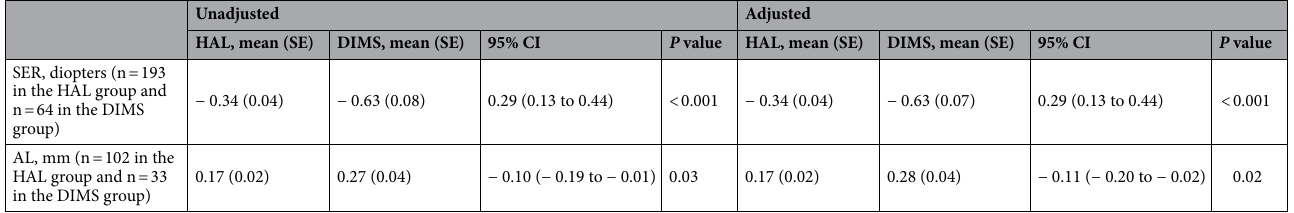
Table 2. Unadjusted and adjusted, standardized 1-year changes in SER and AL. AL axial length, CI confidence interval, DIMS defocus incorporated multiple segments, HAL highly aspherical lenslets, SE standard error, SER spherical equivalent